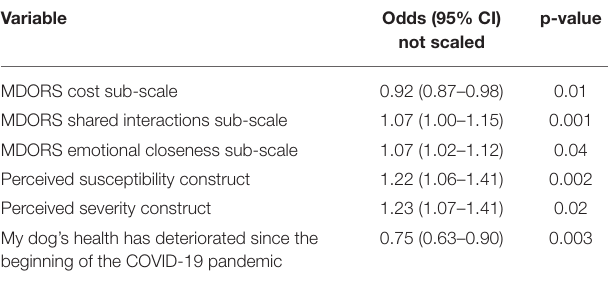
TABLE 9 | Multiple logistic regression model of urgency to seek care given symptoms that could indicate common chronic health conditions performed on the subset of dogs with chronic health condition